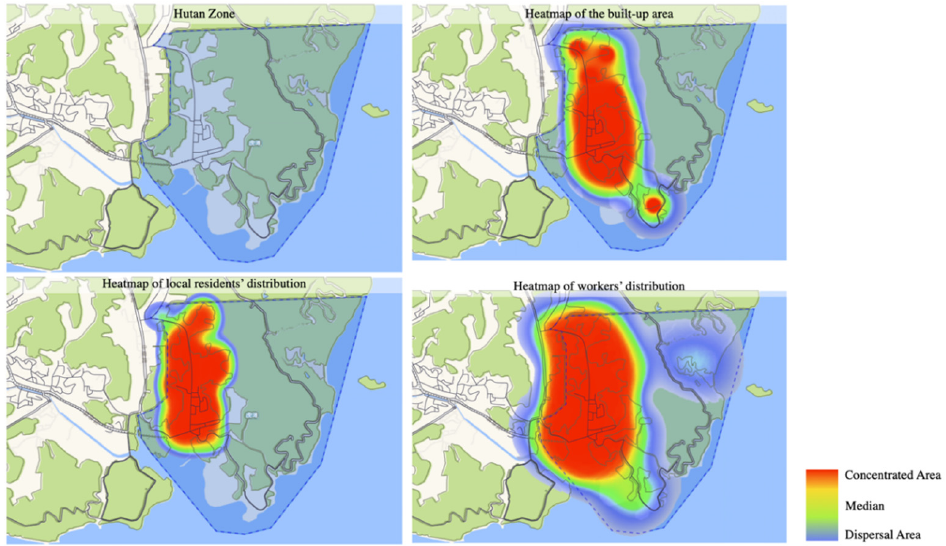
Figure 4. Heatmaps of Hutan Zone. Source: Authors.